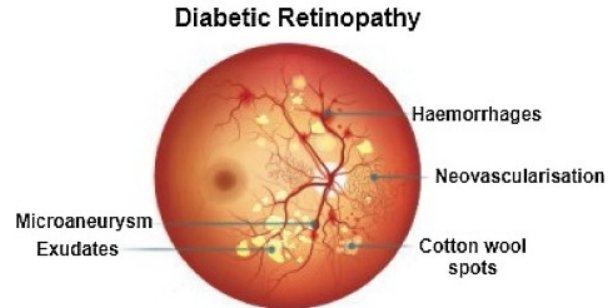
Figure 1. Diabetic retinopathy with microaneurysms.